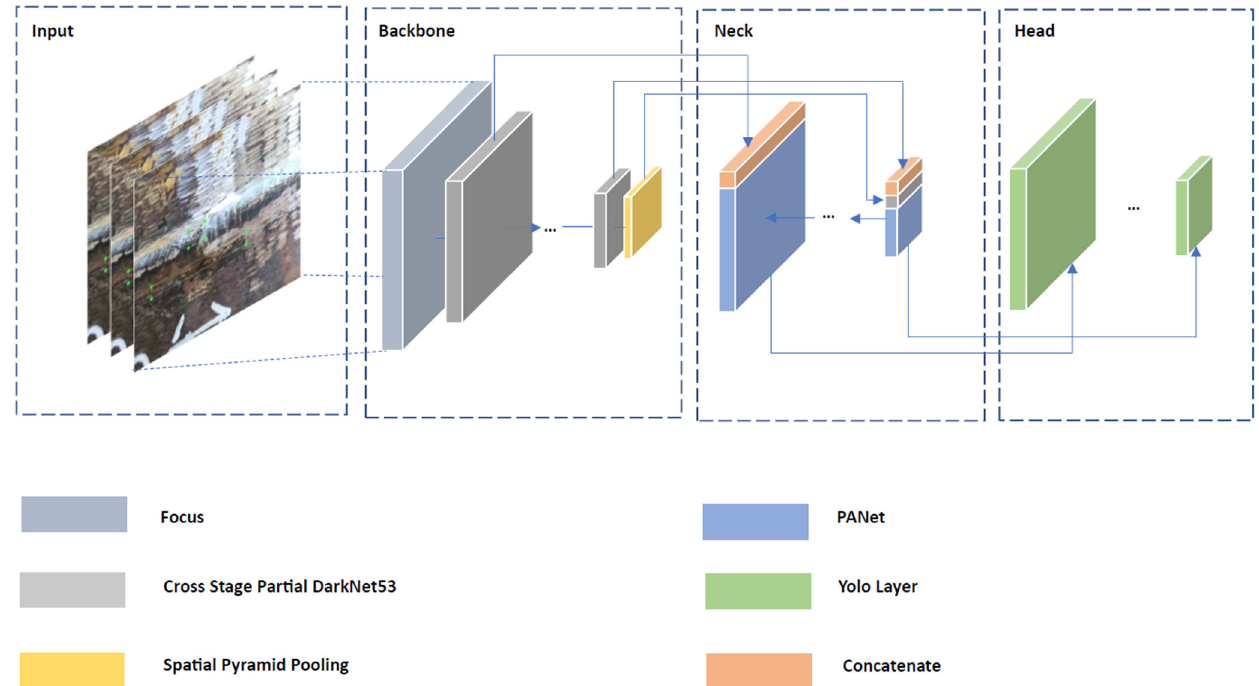
Figure 2. General network architecture of used YOLOv5.